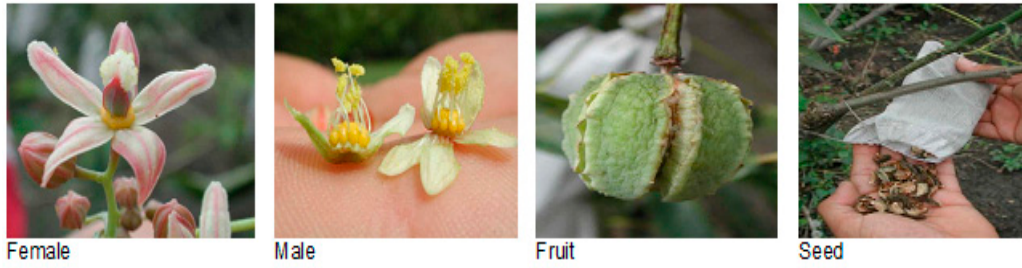
Figure 1. Floral, fruit and seed photos of yam. Photo source: International Institute of Tropical Agriculture (IITA)/Prince E. Norman. Agriculture 2018 , 8 , x FOR PEER REVIEW